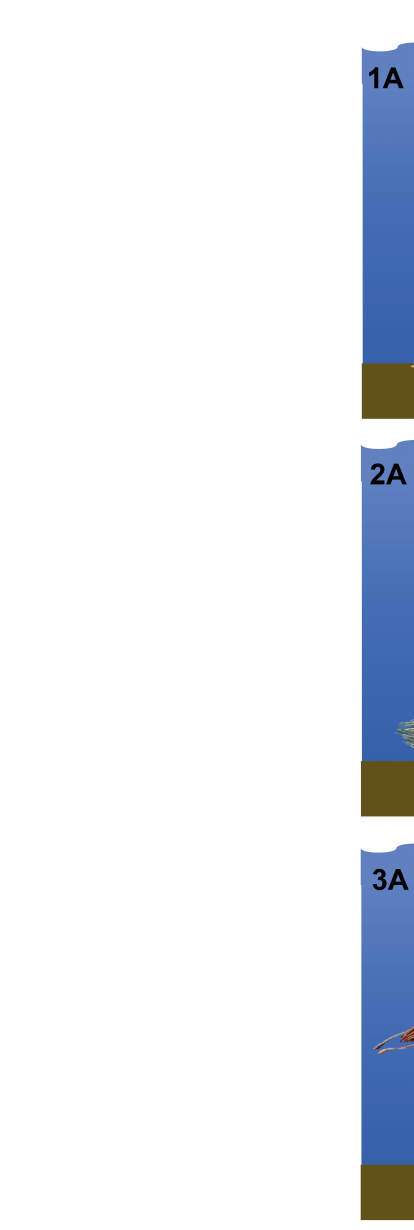
FIGURE 2 Transition from ancestral benthic shelled molluscs to modern cephalopods with a reduced and internalised or absent shell: (1A) . The ancestor of cephalopods is generally considered to be a monoplacophoran mollusc, similar to fossil Knightoconus antarcticus from the Anarctic Cambrian Minaret Formation (image shows a reconstruction of Knightoconus antarcticus , image credit: HannahMoss, CC BY-SA 4.0); (1B) . Subsequently, the fi rst cephalopods appeared, with the earliest currently accepted cephalopod fossil being Plectronoceras cambria (image shows a reconstruction of Plectronoceras cambria , image credit: Entelognathus, CC BY-SA 4.0); (2A) . From the Late Cambrian, cephalopods had achieved buoyancy and could ascend from the sea fl oor, coinciding with a radiation of small cephalopod species with tall, curved shells (image shows a reconstruction of Cyrtoceras , image credit: Nobu Tamura, CC BY-NC-ND 3.0); (2B) . From the Early Ordocivian, shell morphology diverged considerably, with the emergence of long straight shells in orthocerids, and coiled shells, fi rstly in nautiloids and later in ammonoids (image shows a reconstruction of Orthoceras regulare , a middle Ordovician orthocerid, and Dactylioceras commune , an early Jurassic ammonoid, image credit: Nobu Tamura, CC BY-NC-ND 3.0); (3A) . From the Early Carboniferous, stem group coleoids internalized their shells (image shows a reconstruction of Youngibelus tubularis , a Jurassic belemnite, image credit: Nobu Tamura, CC BY-NC-ND 3.0); (3B) . The majority of modern coleoids originated during the Jurassic and Cretaceous, after which the shell was further reduced or lost entirely (image credit: see Figure